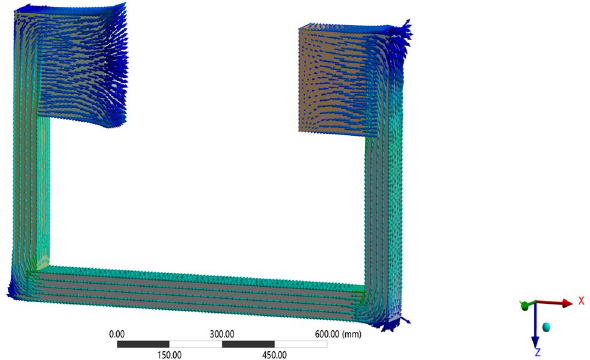
Fig. 5 Simulation model of environmental magnetic field